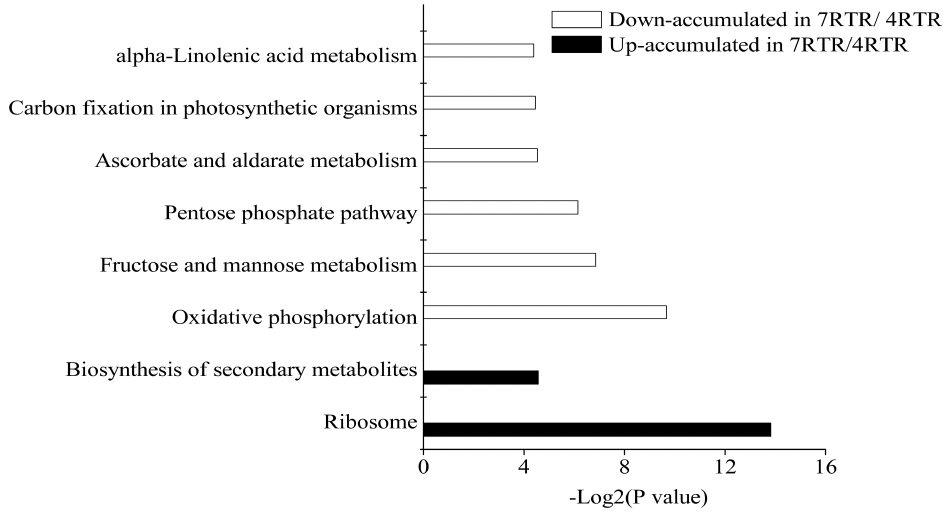
Figure 6. Kyoto Encyclopedia of Genes and Genomes (KEGG) pathway enrichment analysis of DAPs between 7RTR and 4RTR.